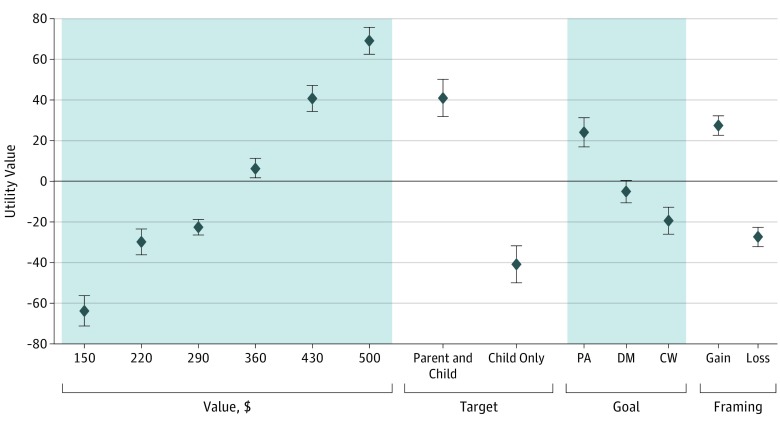
Discrete Choice Experiment ResultsCW indicates change in weight; DM, dietary monitoring; PA, physical activity; and error bars, 95% confidence intervals.